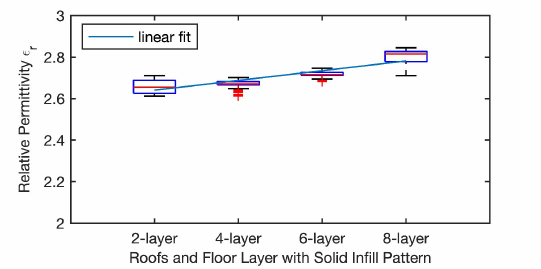
Figure 12. Relative permittivity box figures of solid infill pattern (2–8 roof and floor layers). Table 5. Relative permittivity of solid